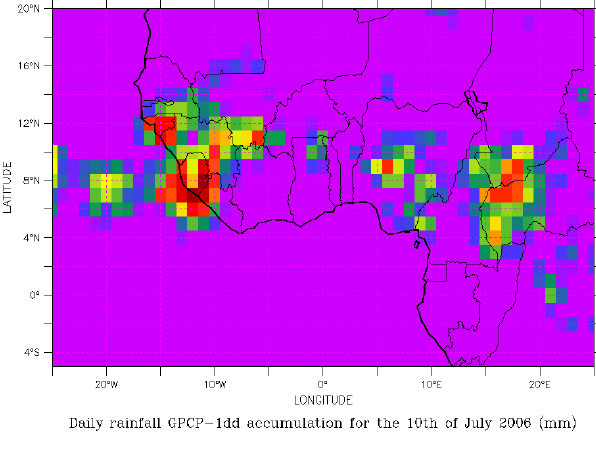
Figure 12. EPSAT-SG daily Rainfall Potential Intensity maps computed with 3B42 product instead of GPCP-1dd.